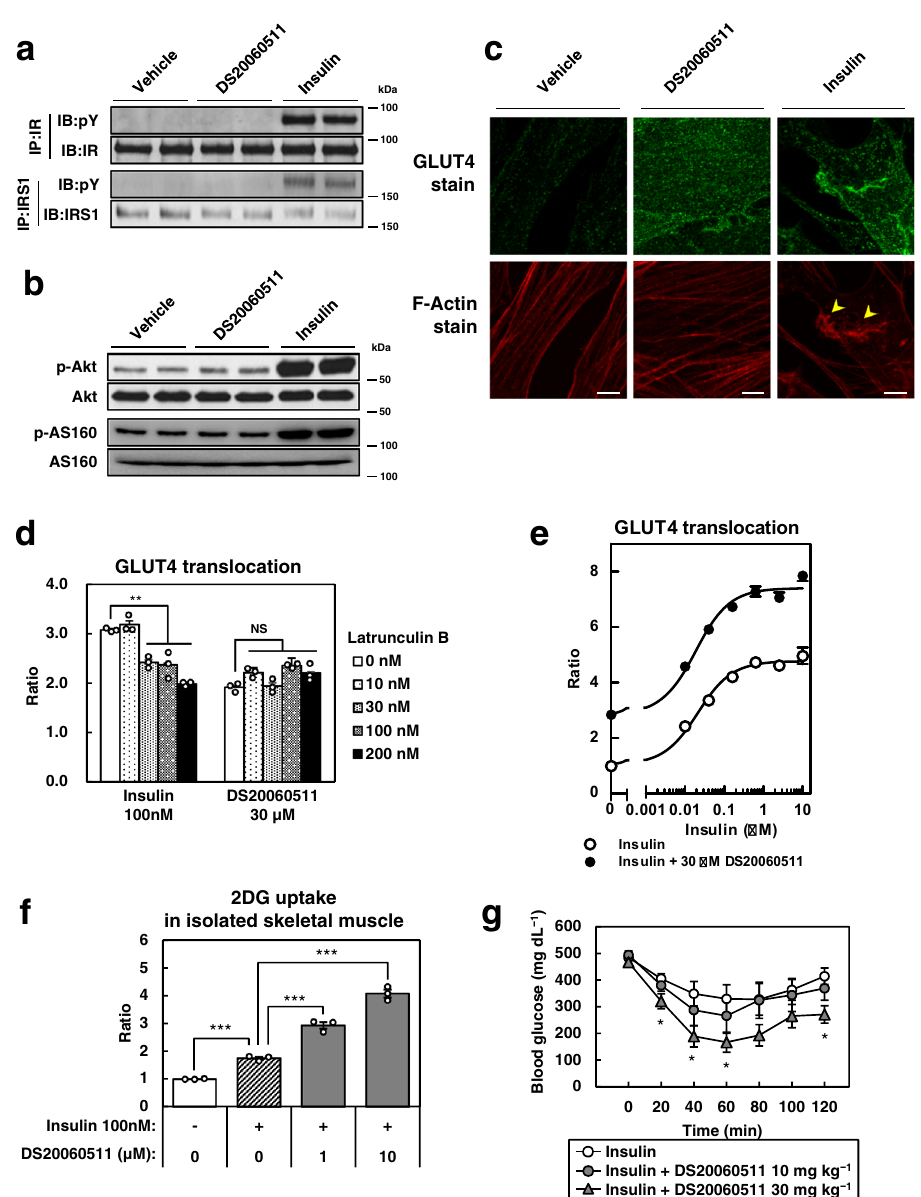
Fig. 4 The mechanism underlying DS20060511-induced GLUT4 translocation is distinct from that of insulin-induced GLUT4 translocation. a , b Phosphorylation of IR β , IRS1, Akt (Ser473), and AS160 of the triceps surae muscle excised from C57BL/6 mice ( n = 2) treated with DS20060511 (10mgkg − 1 ), insulin (5 U kg − 1 ), or saline as vehicle, via inferior vena cava 10min after the treatment. c Fluorescence immunostaining of cell surface GLUT4 and intracellular actin fi bers in L6-GLUT4myc myotubes treated with 30 μ M of DS20060511 or 100nM of insulin. Arrowheads indicate the characteristic ruf fl ed structure of the polymerized actin and actin-associated surface GLUT4. d GLUT4 translocation activity of 30 μ M DS20060511 or 100nM insulin in the presence of the actin polymerization inhibitor, Latrunculin B, at the indicated concentrations. Values shown are means±SEM, n = 3. ** P <0.01 vs. 0nM Latrunculin B by one-way ANOVA followed by Dunnett ’ s test. e Concentration-dependent insulin-stimulated GLUT4 translocation in L6-GLUT4myc myotubes with or without 30 μ M DS20060511 ( n = 3). f Concentration-dependent DS20060511-stimulated 2-DG uptake with 100nM insulin in isolated muscles from C57BL/6 mice ( n = 3). Values shown are means±SEM. *** P <0.001 by one-way ANOVA followed by Tukey ’ s test. g Blood glucose levels during ITT in STZ-treated C57BL/6 mice ( n = 6 – 7). Vehicle or indicated dose of DS20060511 was given orally at the same time as 0.1 U kg − 1 insulin injection intraperitoneally. Values shown are means± SEM. * P <0.05 vs. vehicle by one-way ANOVA followed by Dunnett ’ s test. c Scale bar in all panels, 5 μ m. Uncropped blots for a and b can be found in Supplementary Fig.